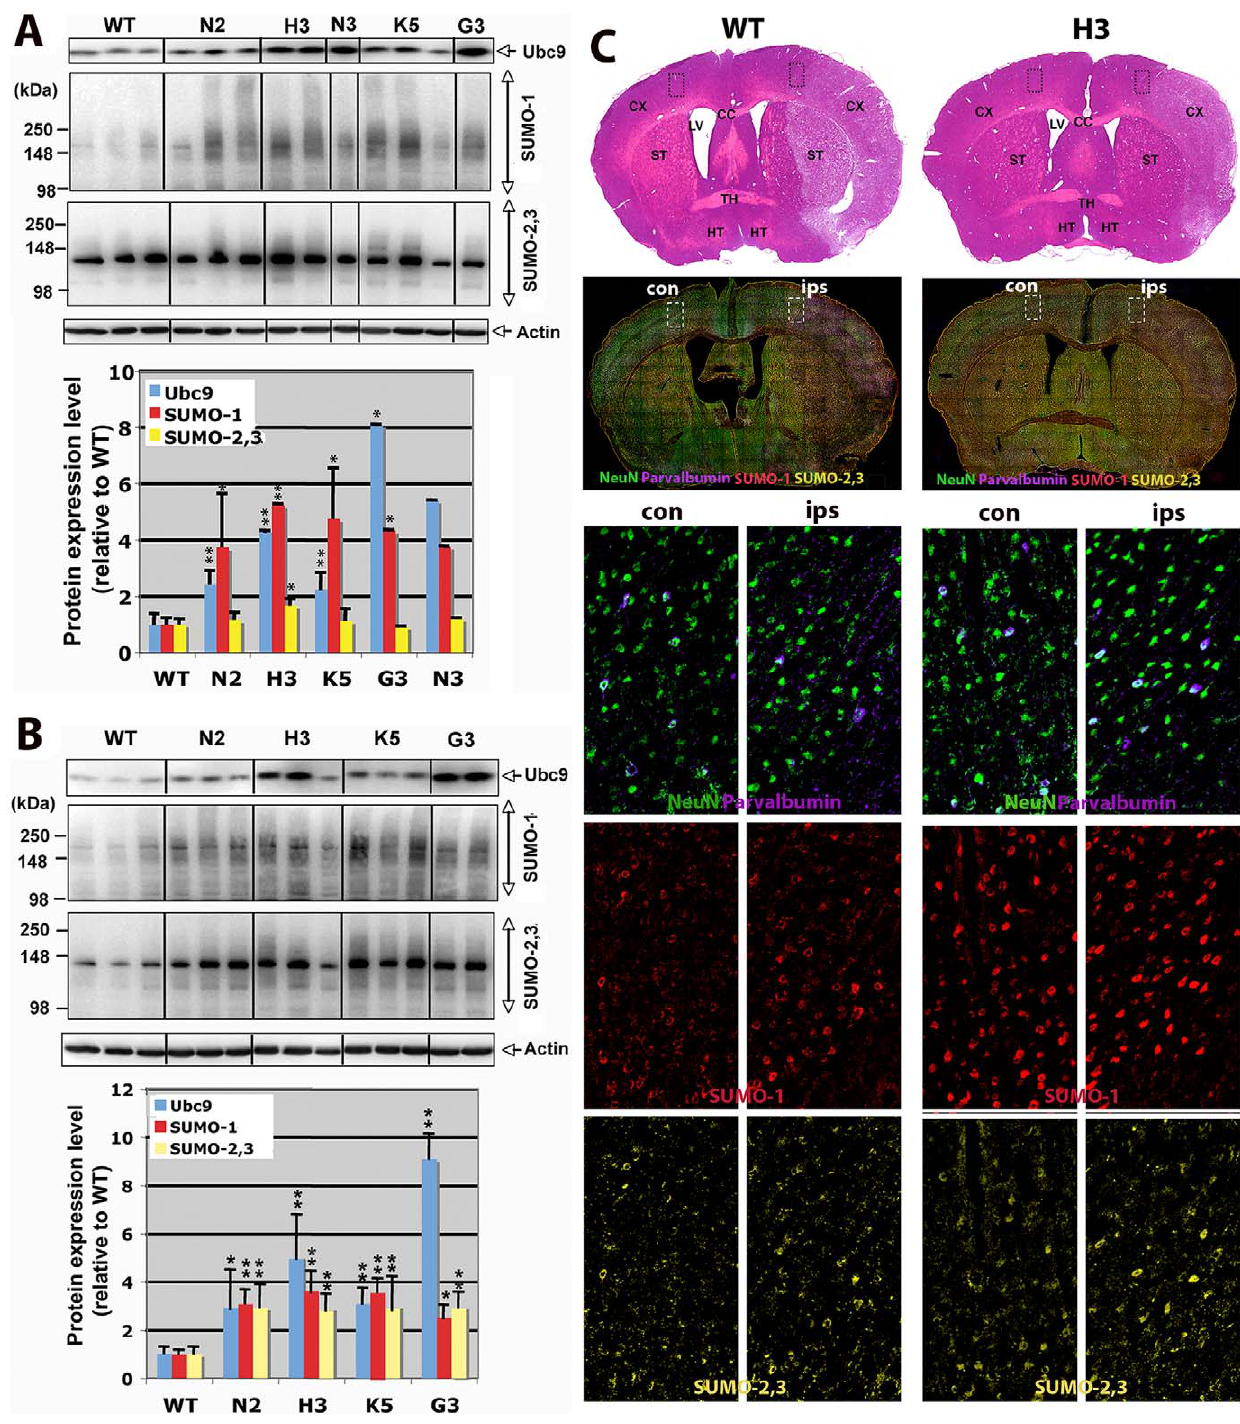
Figure 3. SUMO-1 and SUMO-2,3 conjugation levels in brains of WT and Ubc9 transgenic mice with and without MCAO surgery. (A) Top panel: A representative immunoblot of high molecular weight (HMW) (100 , 300 kDa) conjugates of SUMO-1 and SUMO-2,3 along with Ubc9 and actin in brain samples from WT and Ubc9 transgenic (N2, H3, N3, K5, G3) mice without MCAO surgery. Bottom panel: Quantitative analysis of Ubc9, SUMO-1 HMW-conjugates and SUMO-2,3 HMW-conjugates. Intensities were measured, normalized to actin in each sample, and plotted relative to WT average level. n=3–5 per group (mean 6 SD; except N3, n=1). *P , 0.05, **P , 0.01. (B) Comparable immunoblot (top panel) and quantitative analysis (bottom panel) of Ubc9, SUMO-1 and SUMO-2,3 HMW-conjugates from mice after MCAO surgery. Data are shown as the mean with standard deviation of 4–10 samples in each animal group. *P , 0.05, **P , 0.01. (C) Immunofluorescence analysis of SUMO-1 and SUMO-2,3 protein distributions in infarcted brains. Top row, H&E staining of coronal brain sections from WT and Ubc9 transgenic (H3) mice after 24 h pMCAO. CX, cerebral cortex; CC, corpus callosum; LV, lateral ventricle; ST, striatum; TH, thalamus; HT, hypothalamus. The second row from the top, comparable coronal brain sections from WT and H3 mice immunostained for SUMO-1 (red), SUMO-2,3 (yellow), NeuN (green) and parvalbumin (purple). con, contralateral side; ips,